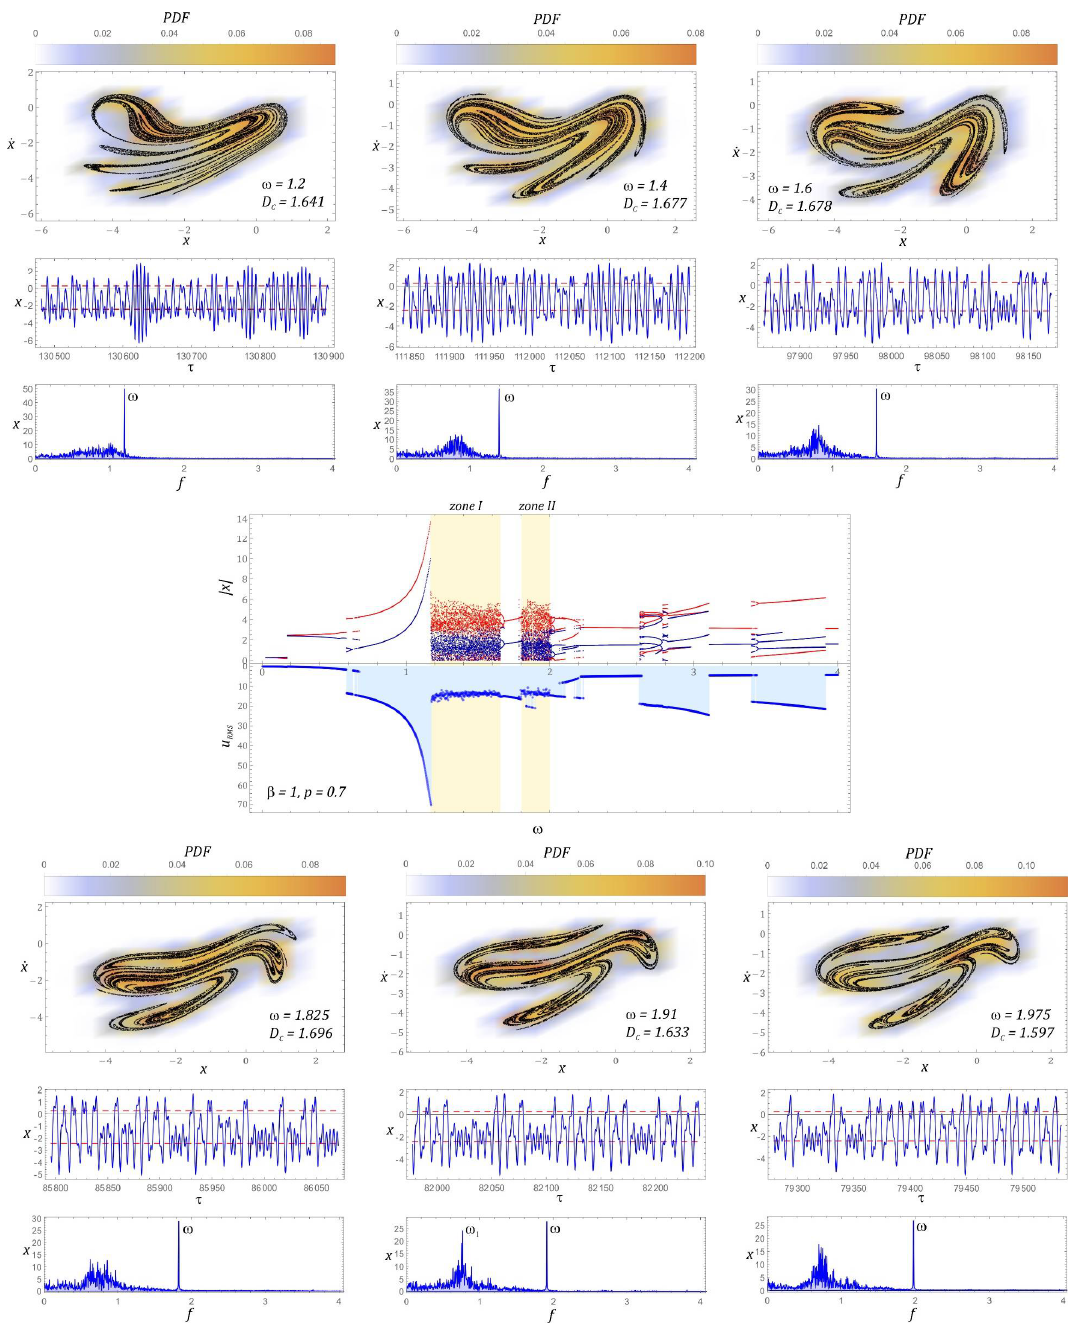
Figure 6. Bifurcation diagram correlated by the frequency spectra with the diagram of RMS voltage induced on piezoelectric electrodes and examples of chaotic responses (Poincaré maps with correlation dimension and probability density function (PDF) indicated).